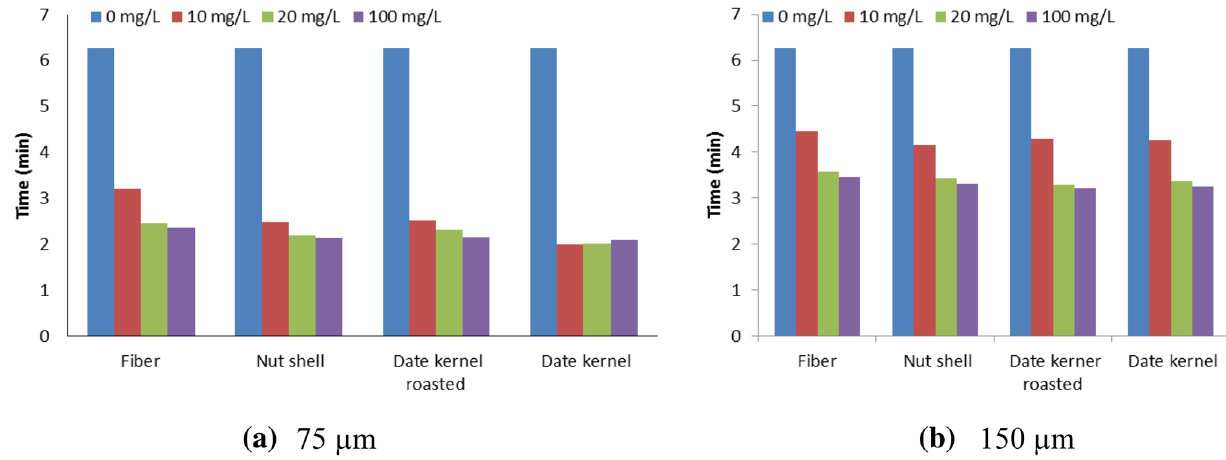
Fig. 2 Flowing time of light crude oil using bio materials